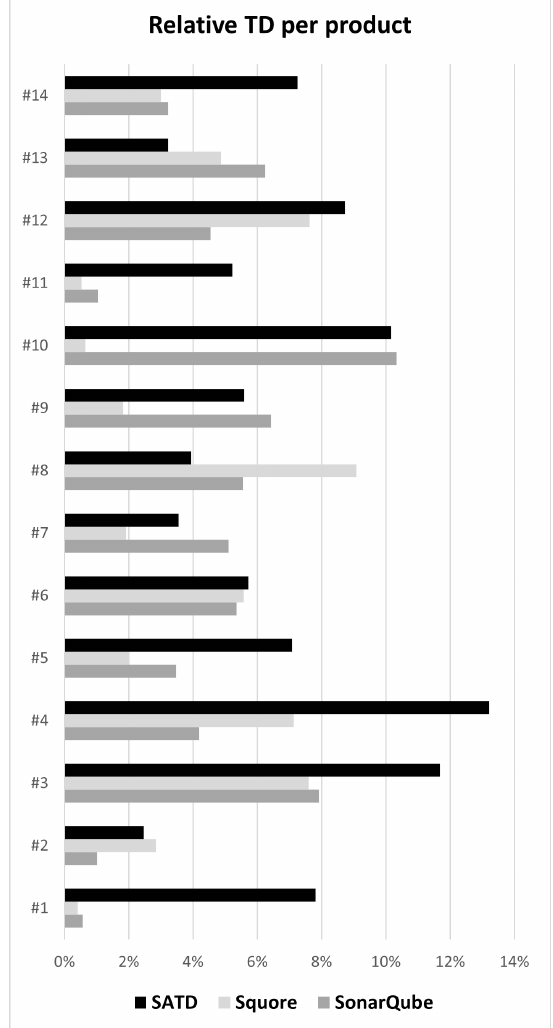
Figure 2. Measured and self-admitted technical debt values per